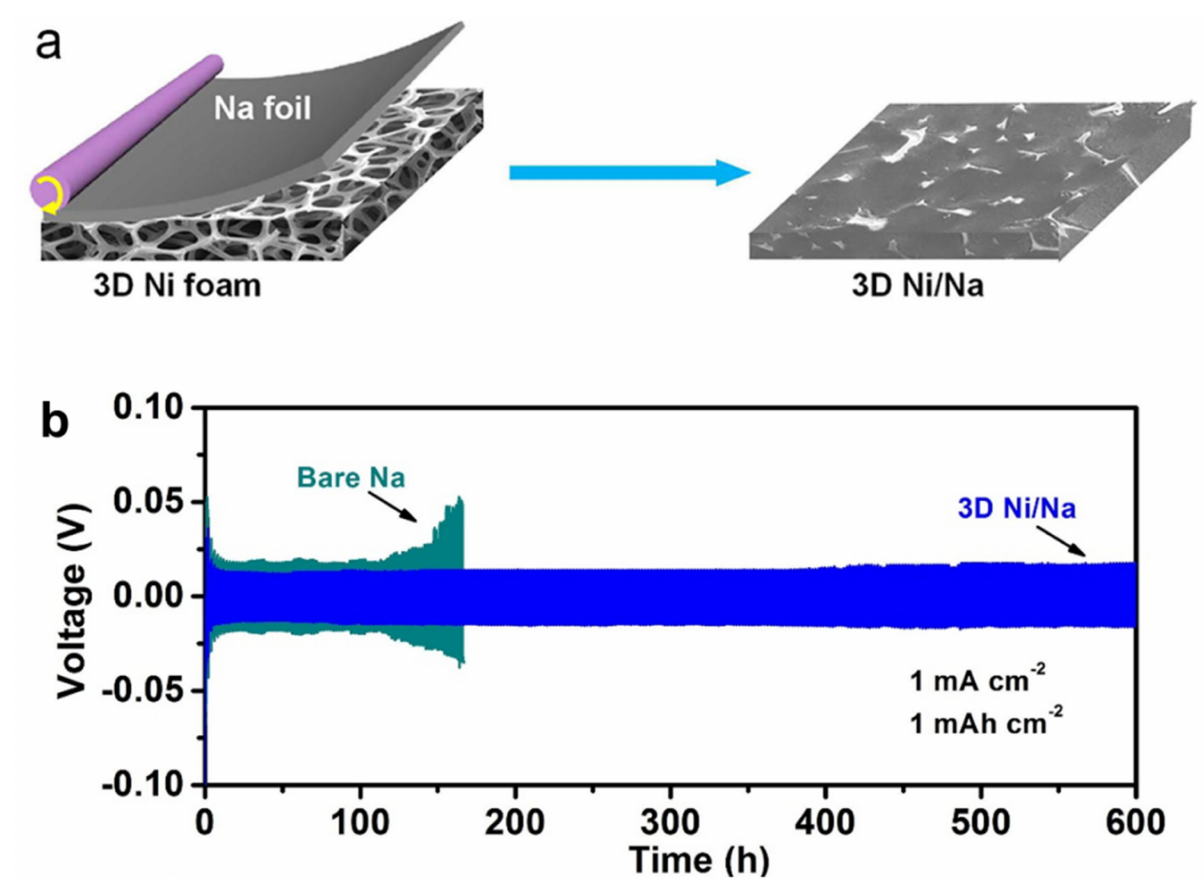
Figure 30. ( a ) Fabrication of 3D Ni/Na anode. ( b ) Voltage profile at 1 mA cm − 2 for bare Na and Ni/Na (adapted with permission from [434]. Mat Lett., Elsevier,